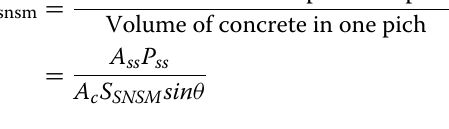
Eq. 1 (Chalioris and Karayannis 2013).